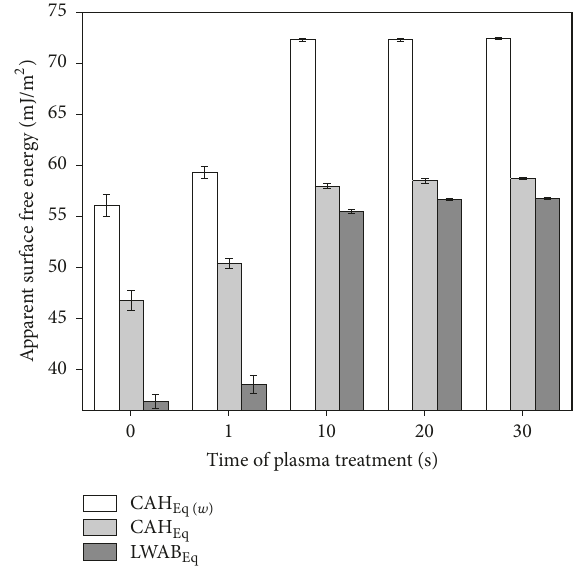
Figure 3: Advancing and receding formamide contact angles measured on the paper composite surface.